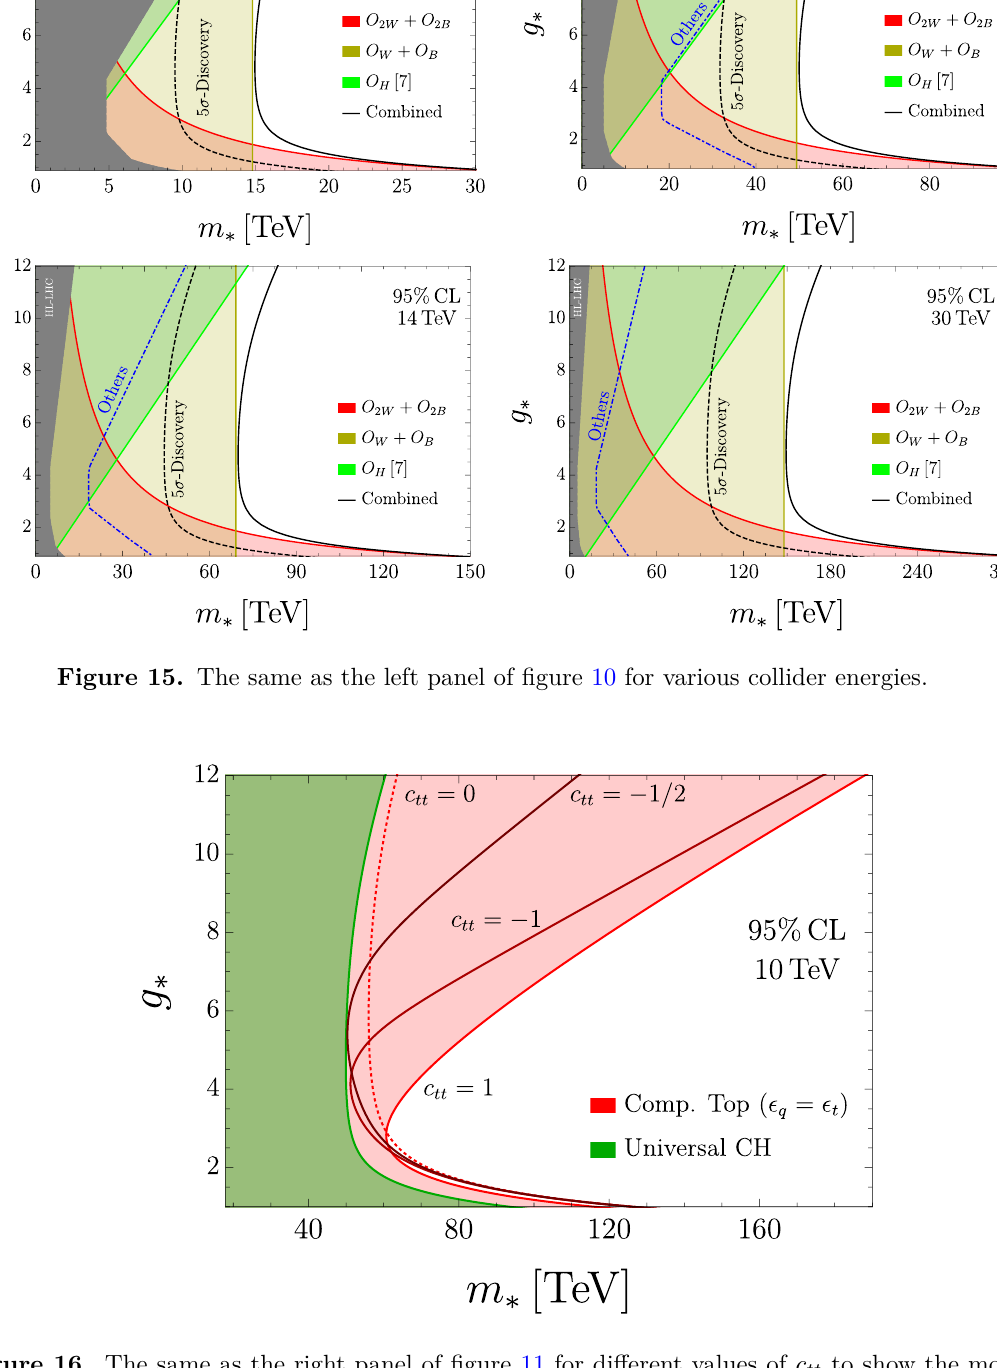
Figure 16. The same as the right panel of figure 11 for different values of c tt to show the model dependence of the